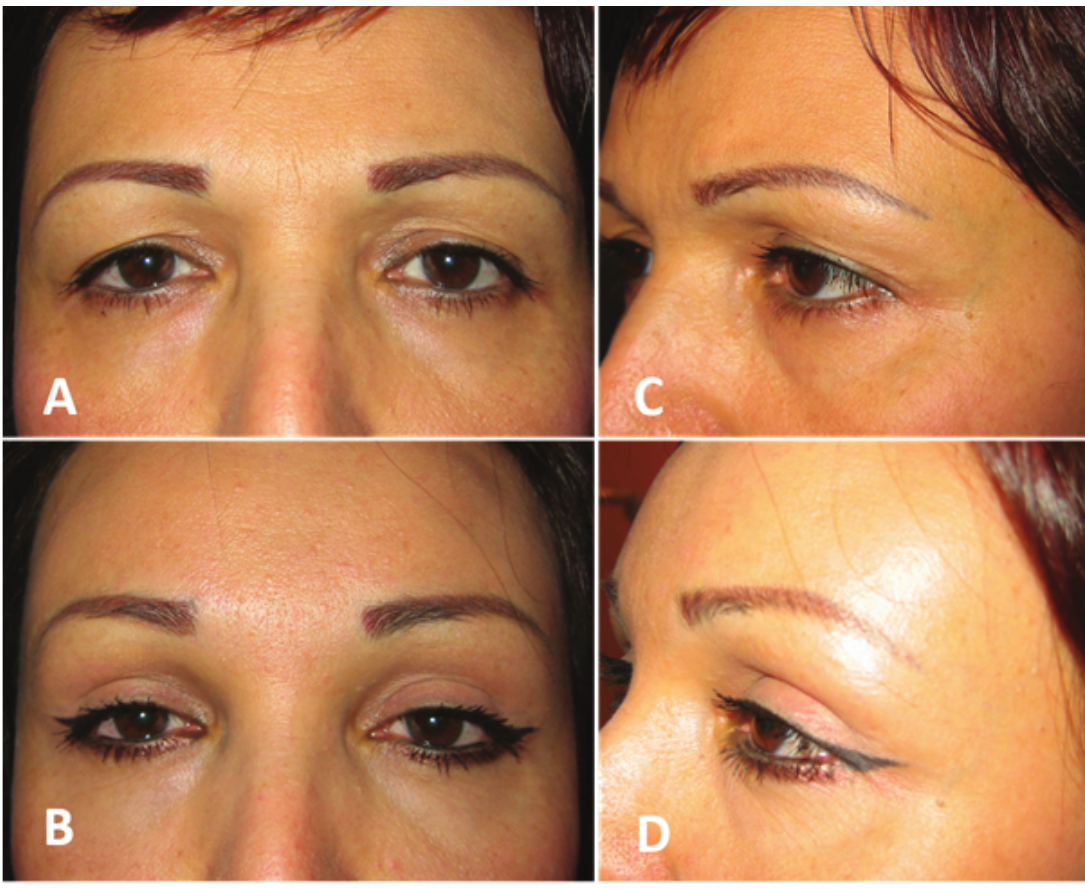
Figure 10. Before (A & C) and two years after (B & D) endoscopic forehead lift and upper blepharoplasty in a female in whom medial and lateral eyebrow lift are visible.